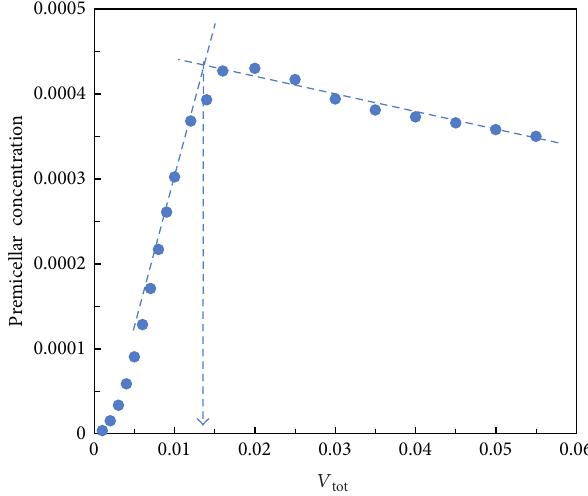
(cid:2395) (cid:85)(cid:80)(cid:85) F 3: Premicellar number density (summation of with ) of surfactant. e ) versus total volume fraction ( tot T ) as a double chain surfactant. Maximum graph belongs to (H 𝑛𝑛𝑋𝑋 𝑛𝑛 concentration is found near to CMC. Aer CMC, premicelles 𝑛 ≤ 𝑛𝑛 ≤ 10 𝑉𝑉 3 3 𝑛 remain nearly